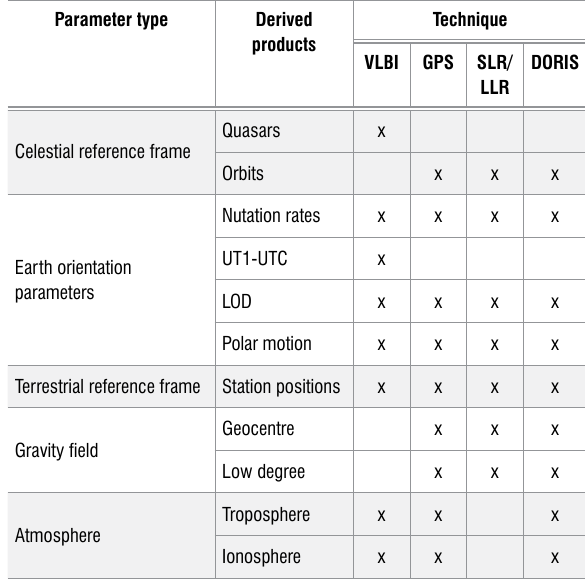
Summary of geodetic techniques and their applications as reported in Rothacher 10